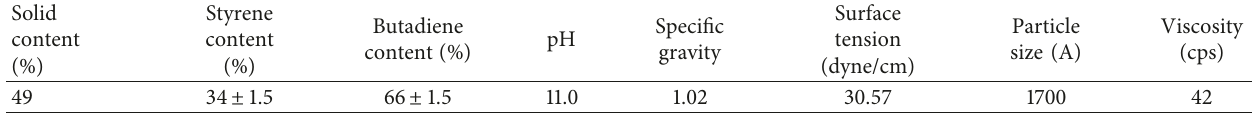
Table 4: Properties of styrene butadiene latex.